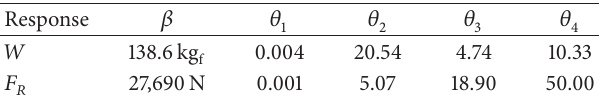
Table 3: Optimal parameters of kriging